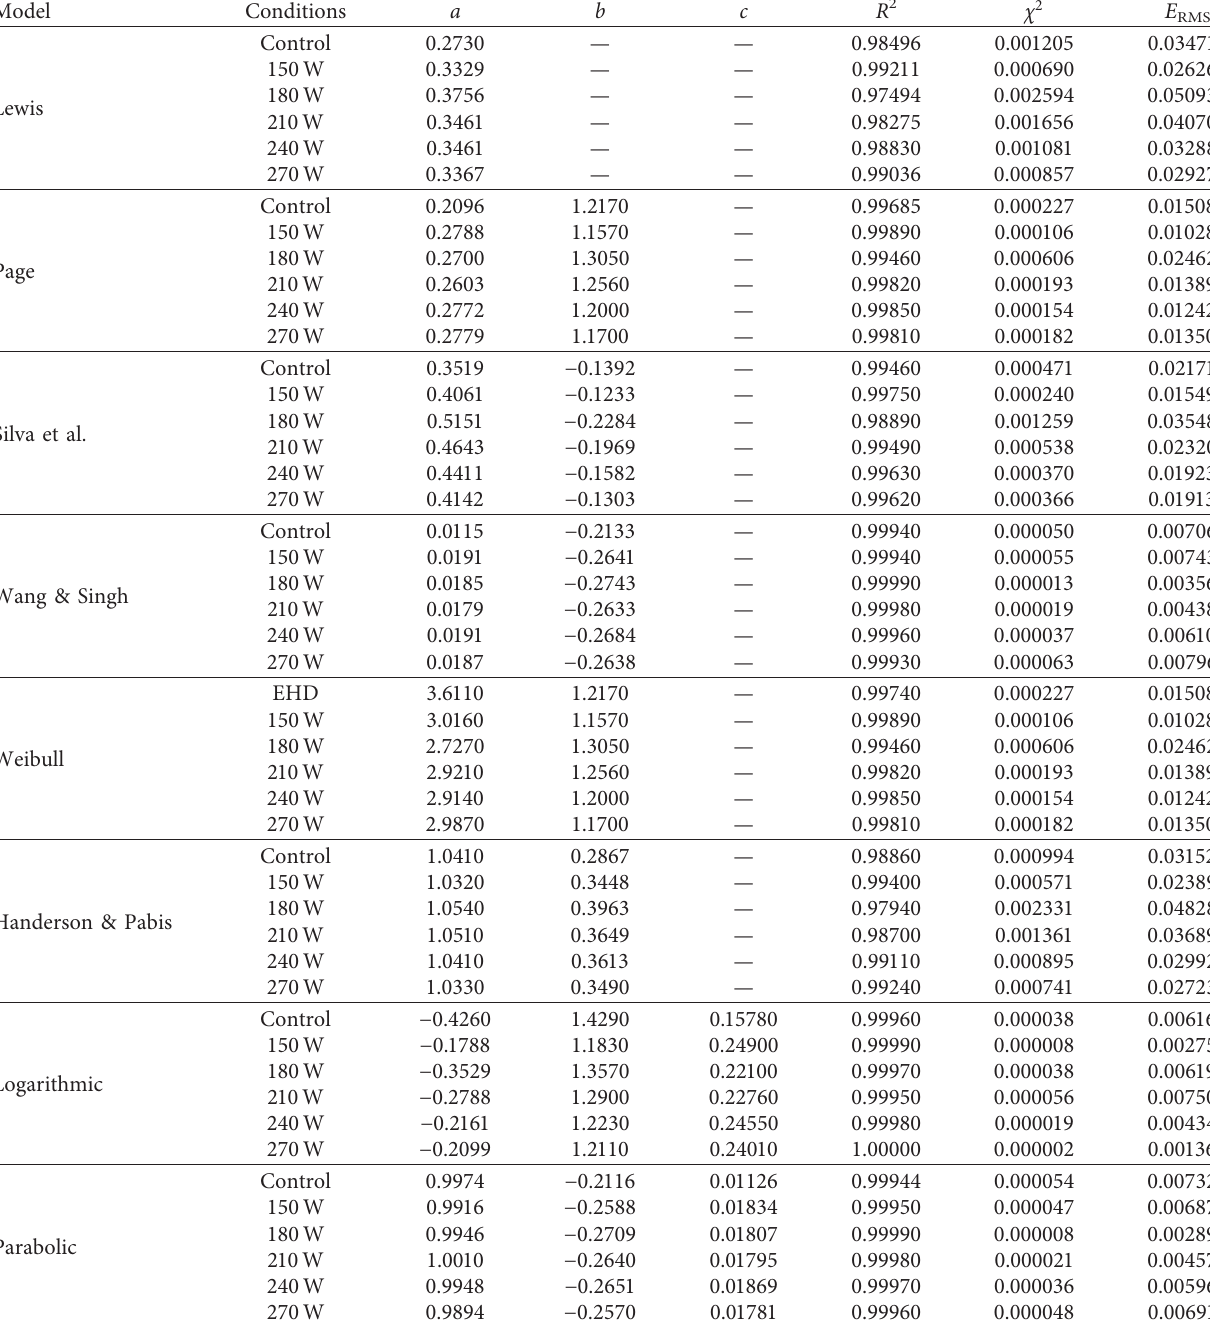
Table 5: Statistical analysis results of moisture ratio and drying time